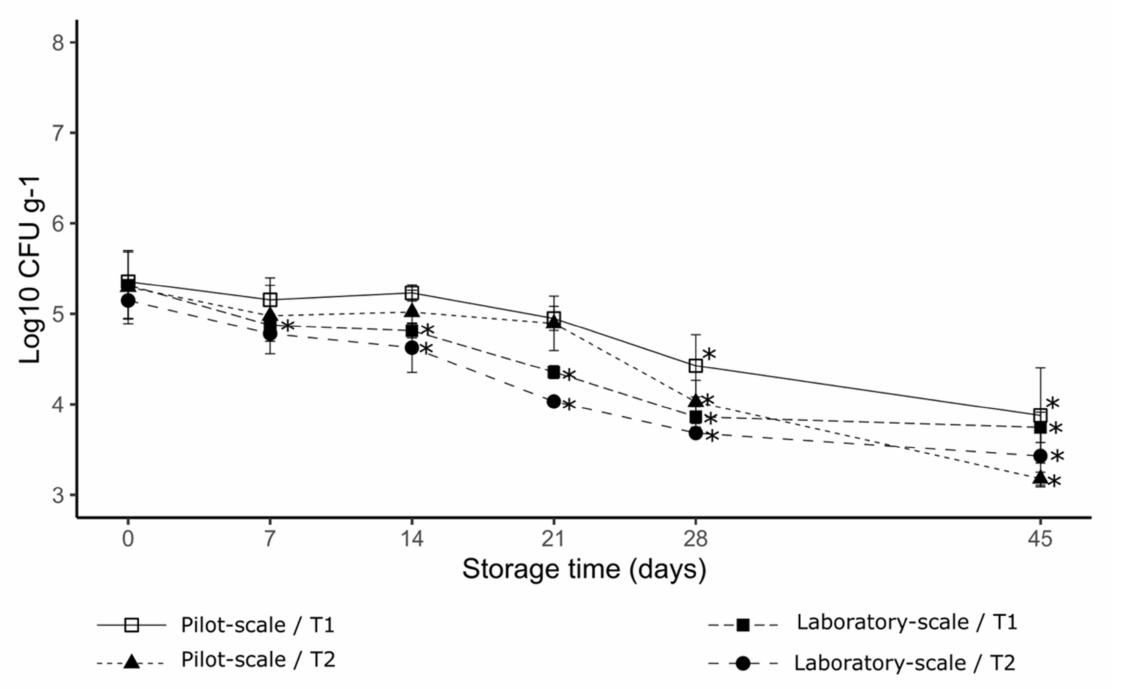
Figure 2. The effect of emulsifying salts on the inactivation of B. thuringiensis CFBP 4376, with different processing methods over storage time. (*) indicates a significant difference with the zero time of storage, according to Tukey’s test ( p < 0.05). Error bars show standard deviations of the